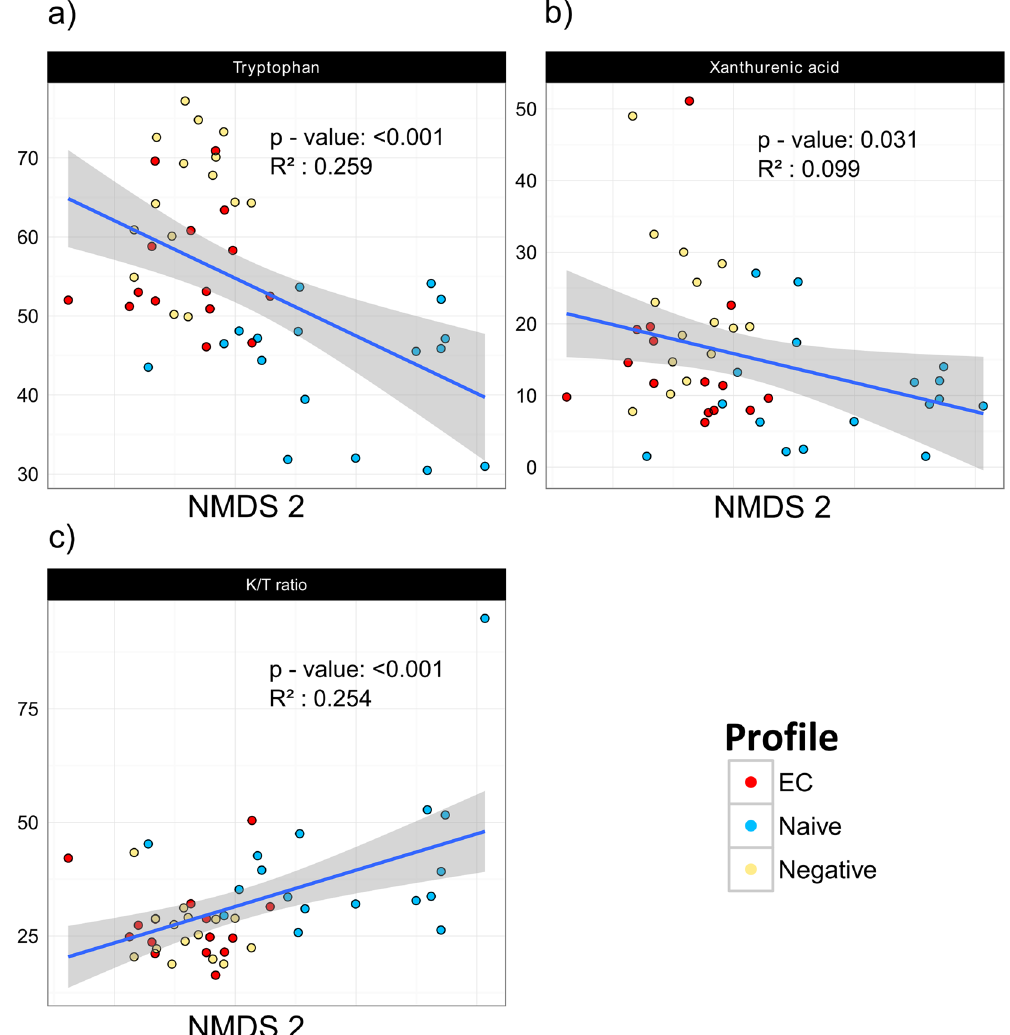
Figure 5. Correlations between tryptophan catabolism metabolites and NMDS 2 axis reveal clustering of naive patients. Significant correlations between NMDS 2 axis and tryptophan ( a ), xanthurenic acid ( b ) and K/T ratio ( c ) were observed, separating naive patients from EC and negative controls. The gray area defines the 95% confidence interval for the linear regression coefficients. The different groups are represented by different colors (EC-red, naive-blue, negative-yellow). Spearman’s correlation was applied for testing correlations between metabolites and NMDS plot axis